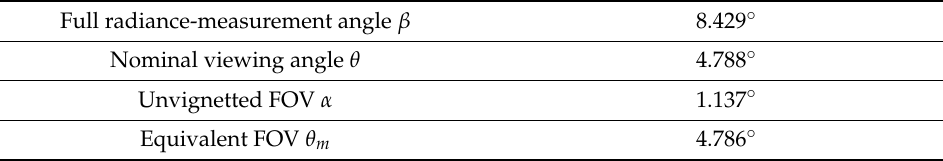
Figure 2. Schematic of FOV. Table 1. Viewing angles of the transfer radiometer.